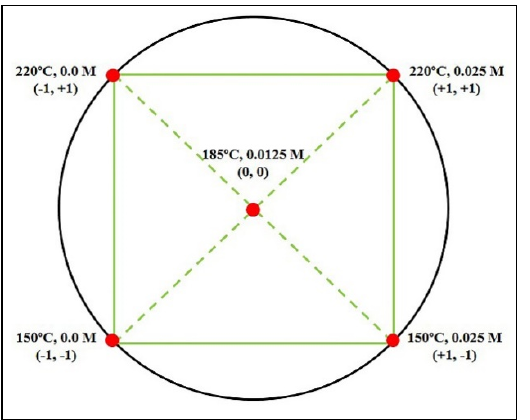
Figure 2. Factorial experimental design (square domain) and star points (circular domain). Each black dot represents a dilute acid pretreatment performed at the variable values indicated. The coded values are bracketed ( − 1 is the lowest value of a variable and +1 is its highest value) and the star points are distributed at a distance of 1.5 from central point.